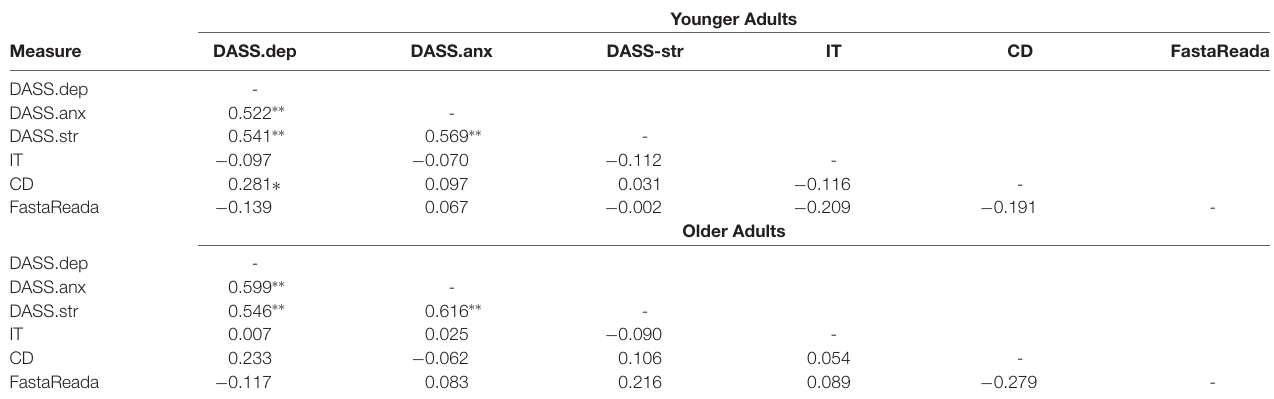
TABLE 2 | Correlation coefficients ( r ) for depression, anxiety, stress scores and performance on IT, CD, and FastaReada for young and older adults. Younger Adults Measure DASS.dep DASS.anx IT CD